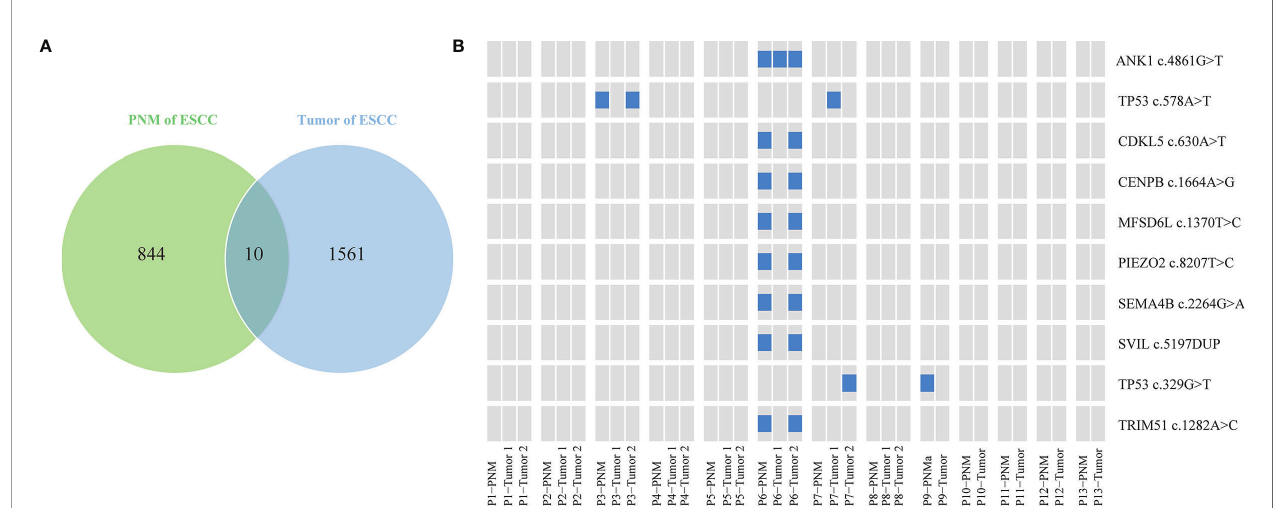
FIGURE 2 | Distribution of the ESCC somatic single nucleotide variants. (A) Venn diagram showing the numbers of unique and shared somatic mutations in ESCC PNM and tumor samples. (B) Schematic diagram showing the distribution of shared mutations by ESCC tumor and PNM in speci fi c patients. The presence of each shared mutation is indicated by the blue box.